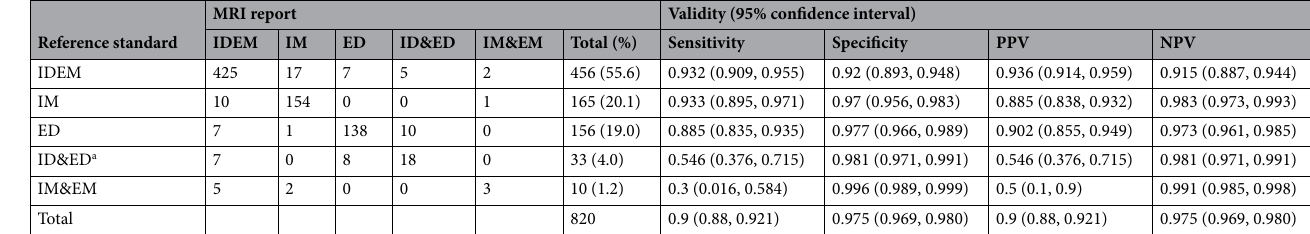
Table 1. The validity of MRI for the location of the tumor. IDEM inradural extra, IM intramedullary, ED extradural, ID&ED both intradural and extradural, IM&EM both intramedullary and extramedullary, PPV positive predictive value, NPV negative predictive